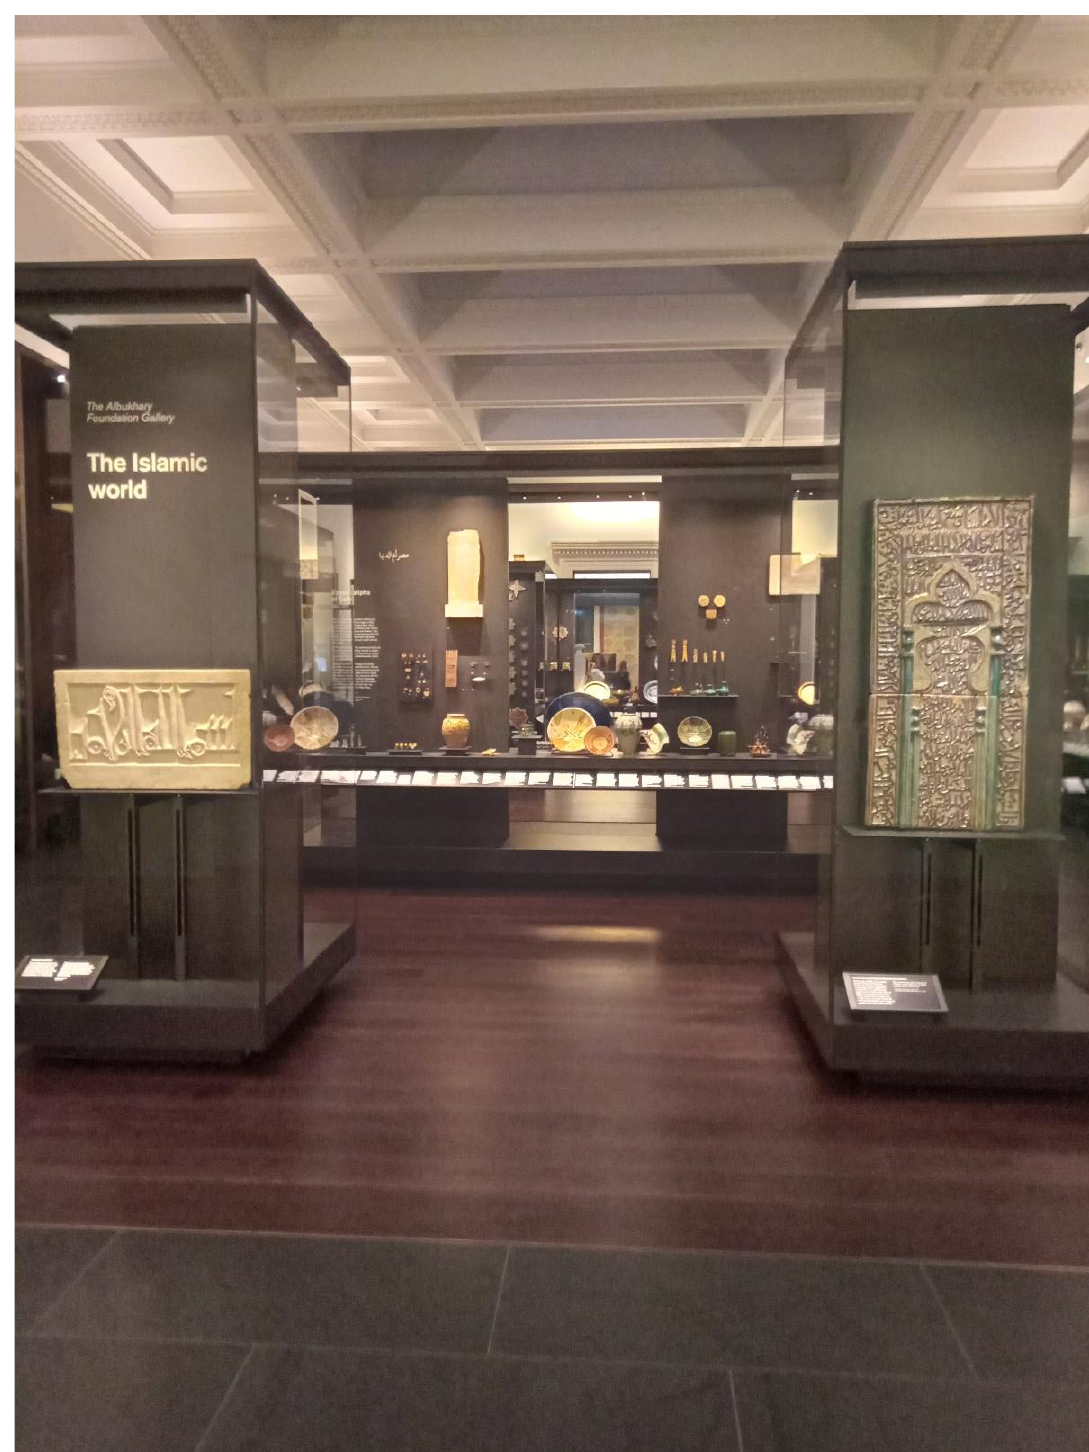
Figure 19. View from the entrance to the Albukhary Gallery, British Museum. Photo of the author.